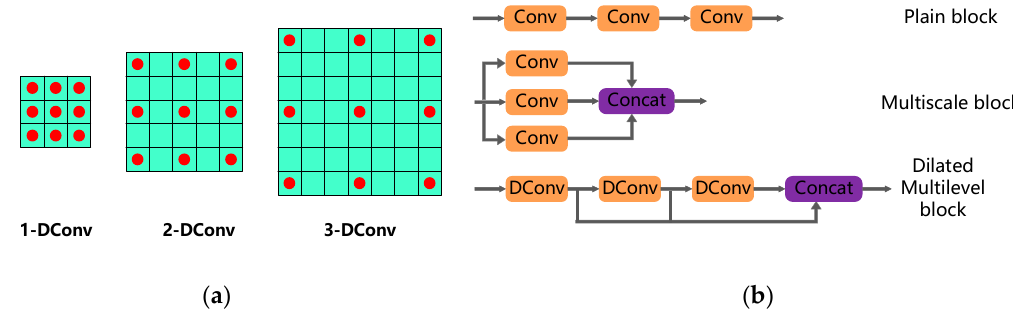
Figure 2. ( a ) Dilated filters with dilation factor s = 1, 2, 3. ( b ) Comparison of different block